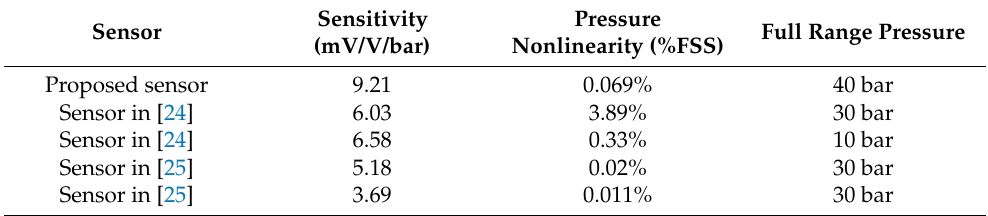
Table 1. Comparison of performance with other pressure sensors at room temperature.